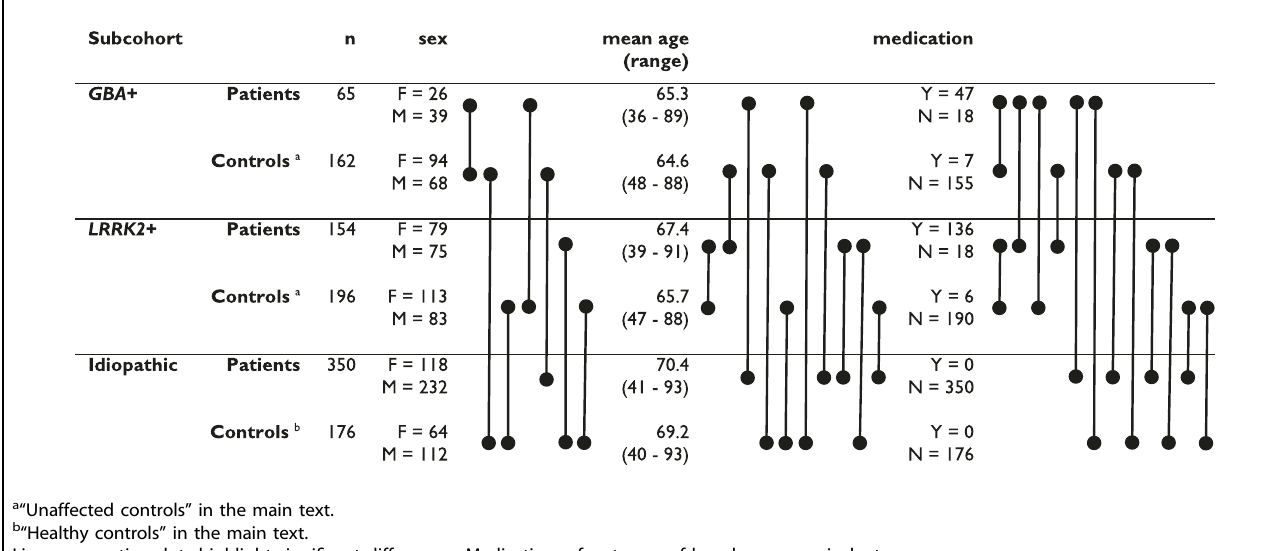
Table 1. Parkinson ’ s disease